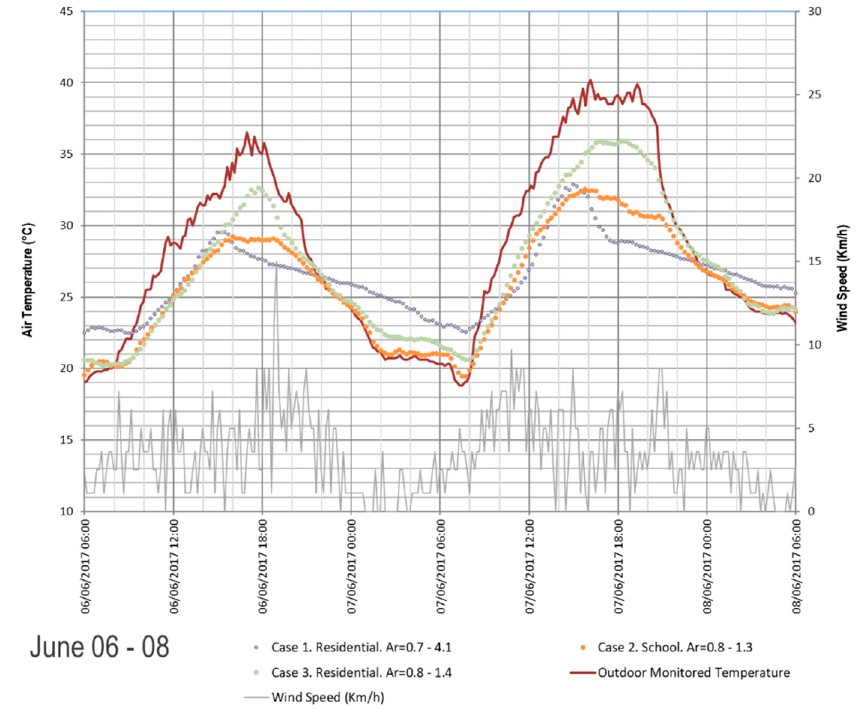
Figure 2. Air Temperature and Wind Speed in courtyards and outside from 6th to 8th